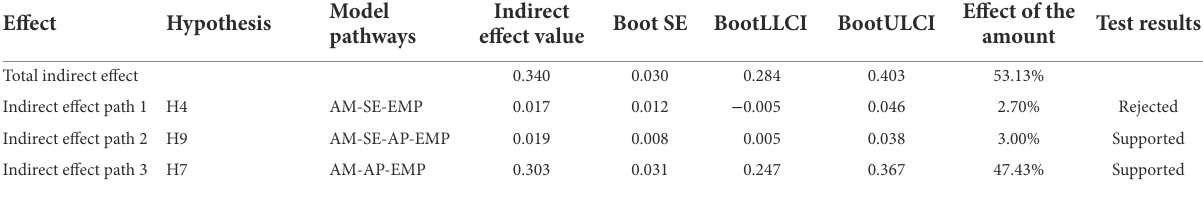
TABLE 6 Mediating effect of self-efficacy and academic performance on the correlation between achievement motivation and